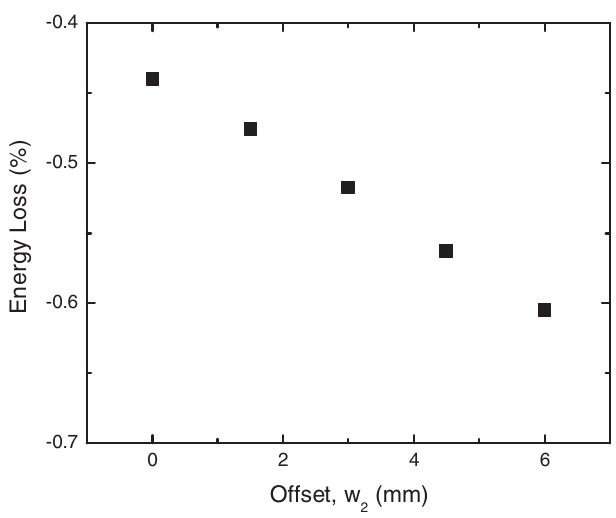
FIG. 12. Mean momentum variation of the muon distribution at the end of M5 as a function of the W 2 apex offset from the beam line center. The apex of W 1 is fixed at the beam line